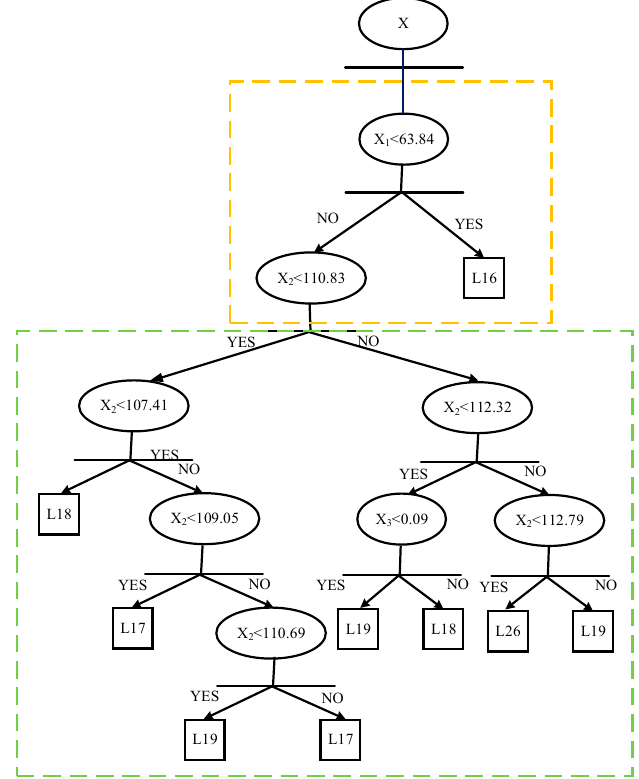
Figure 7. Relay 8 setting for base case.